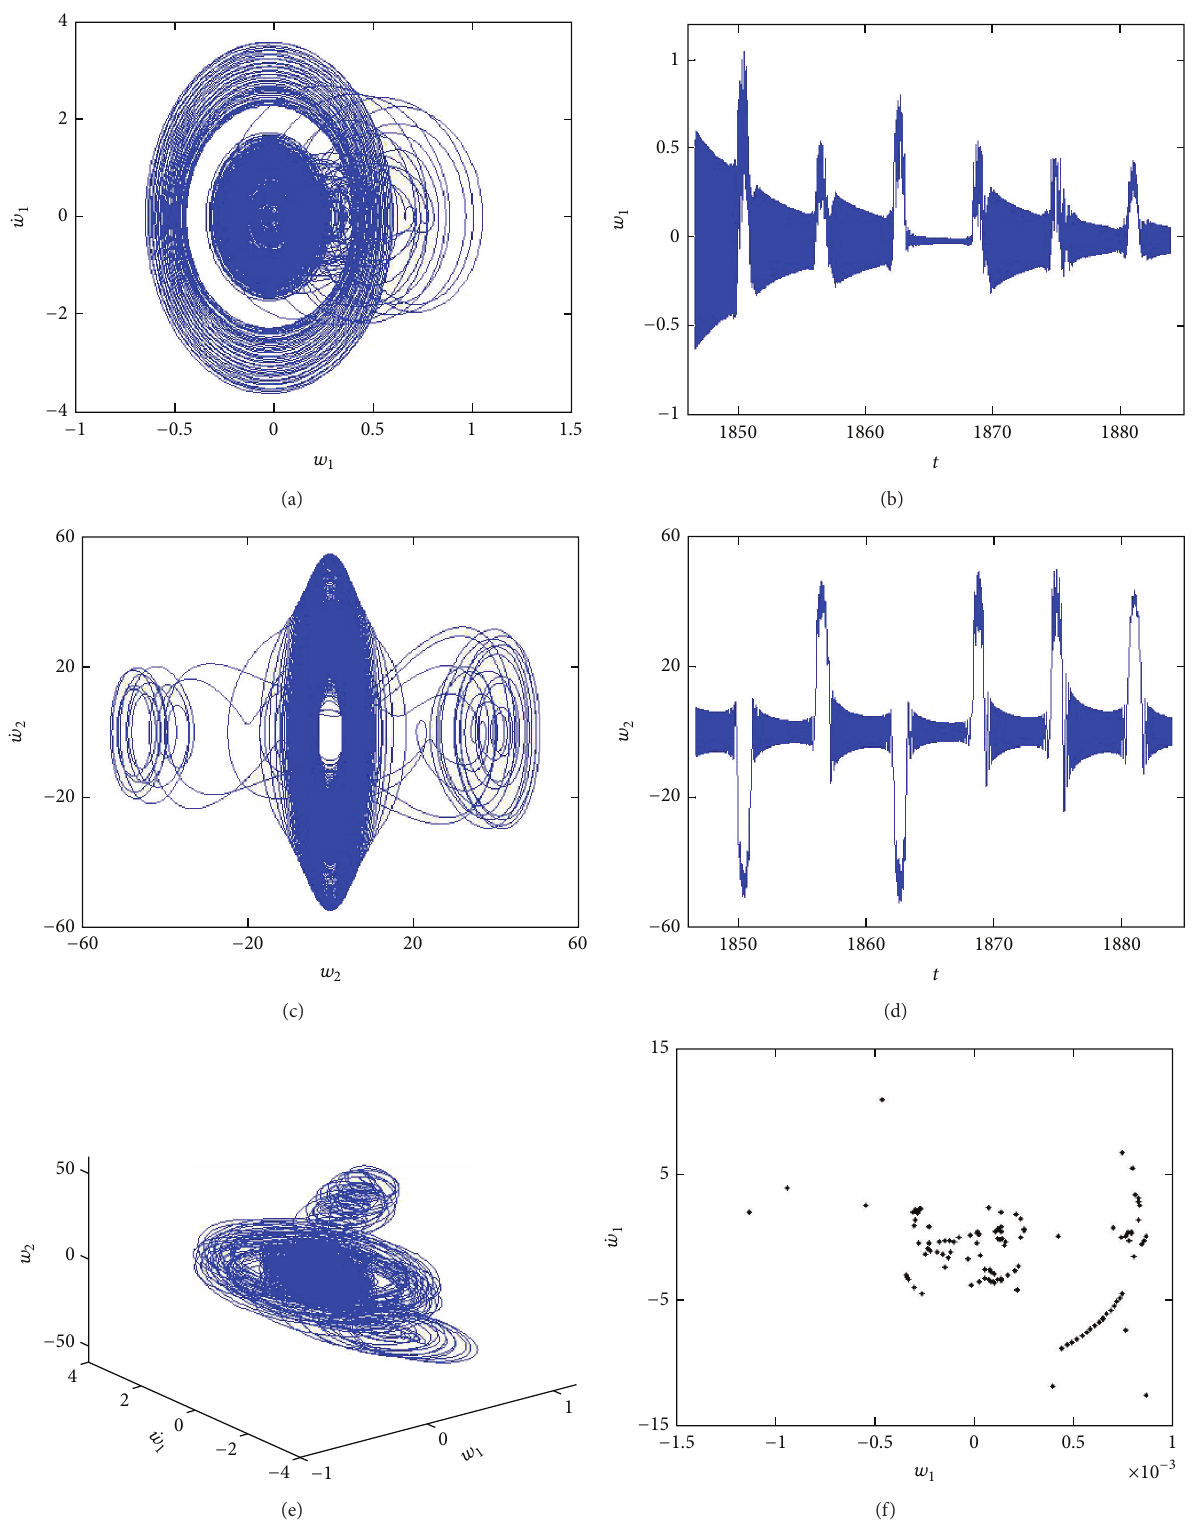
Figure 6: The chaotic motion of the FGM cylindrical panel occurs when the magnitude of the in-plane excitation is taken to be 7.79 × 10 7 . The volume fraction index is taken to be 0.5. The Mach number is taken to be